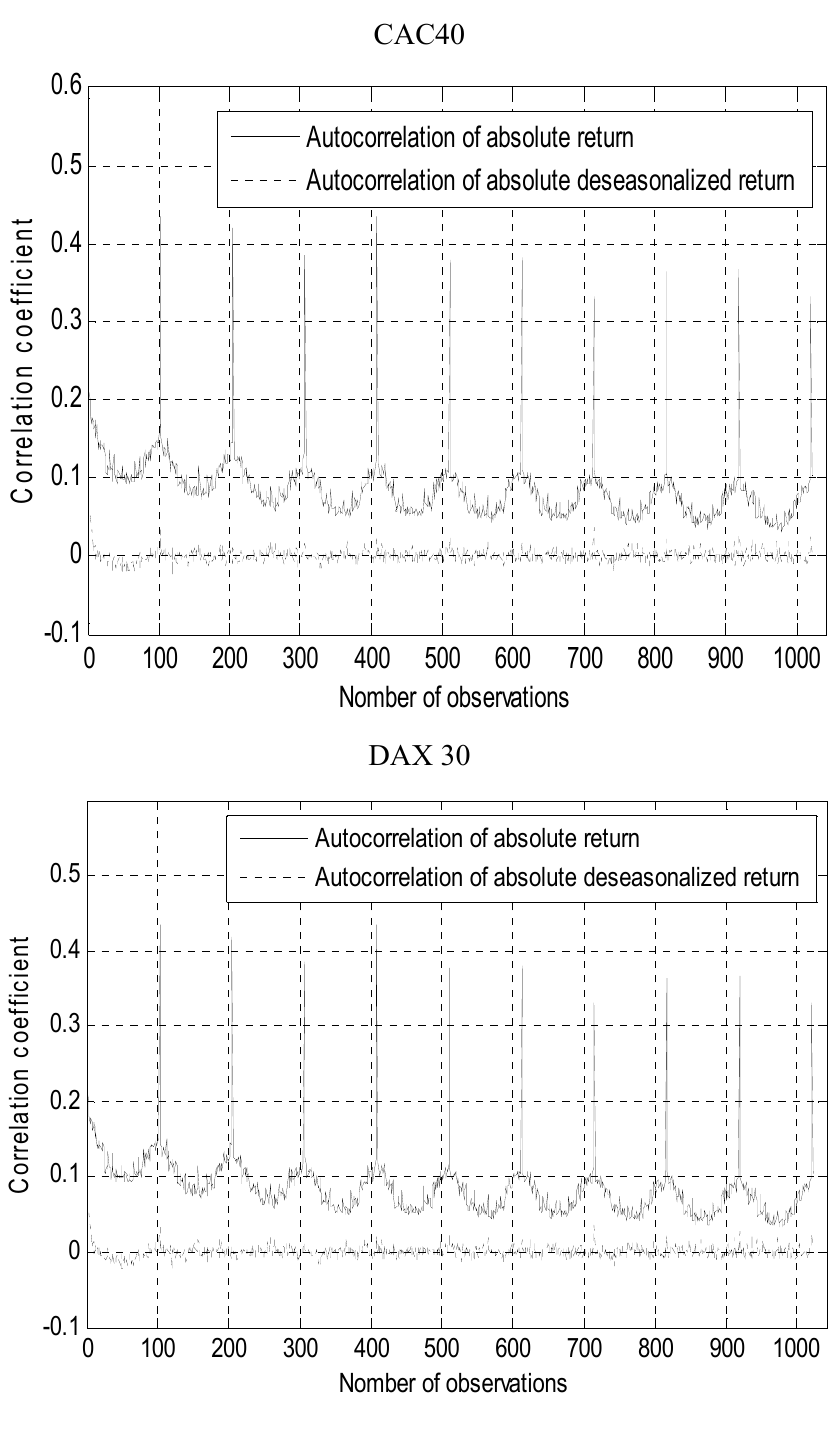
Figure 4. Autocorrelation of intraday absolute and deseasonalized index